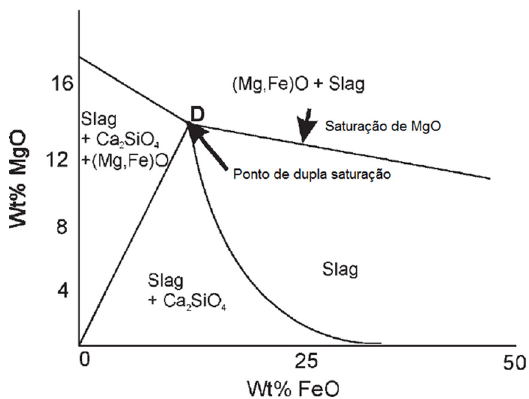
Figure 7: Generic Isothermal Saturation